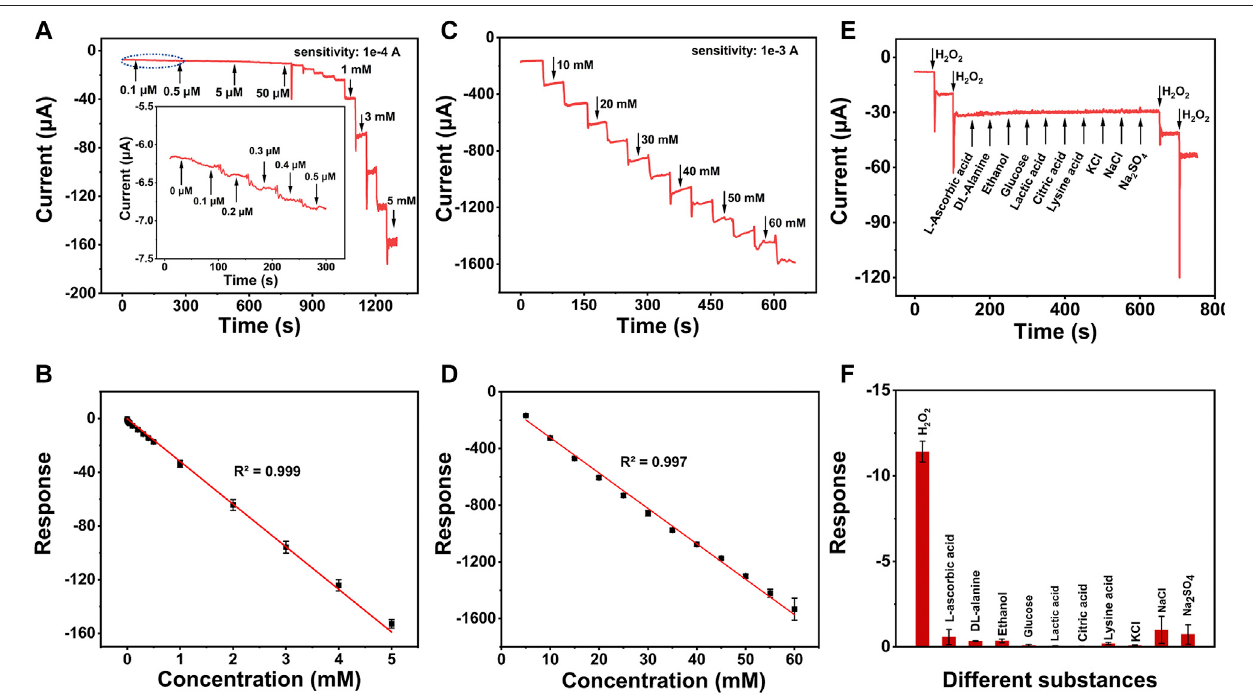
FIGURE4|(A) Amperometric responsesofAu 3 Pt 7 /2DCo-MOF/GCE withthesuccessive addition oflowconcentrationofH 2 O 2 . (B) Thelinearrelationshipsofthe responsecurrentofAu 3 Pt 7 /2DCo-MOF/GCEwiththeH 2 O 2 concentrationsfrom0.1 μ Mto5 mM(R 2 =0.999)and (C) amperometricresponsesofAu 3 Pt 7 /2DCo-MOF/ GCE with the successive addition of high concentration of H 2 O 2 . (D) The linear relationships of from 5 to 60 mM (R 2 = 0.997). (E) Amperometric responses of 5 mM L- ascorbicacid,DL-alanine,ethanol,glucose,lacticacid,citricacid,lysineacid,KCl,NaCl,Na 2 SO 4 ,and 0.5 mMH 2 O 2 inPBSsolutionatanappliedpotentialof − 0.5 V. (F) Histograms of different substances.